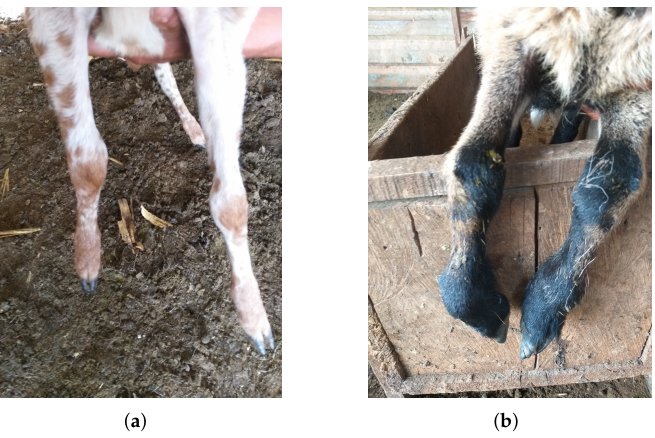
Figure 3. Lamb legs comparison. ( a ) Lamb with normal legs. ( b ) Lamb with deformed